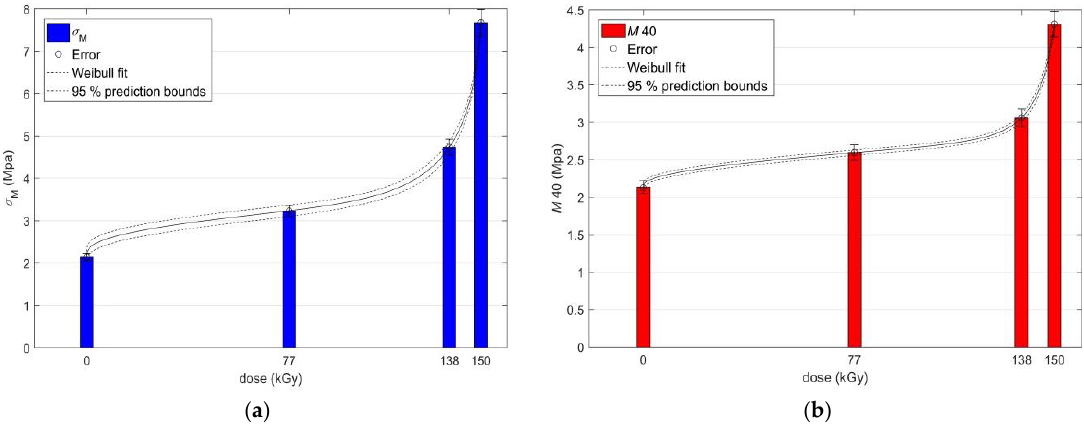
dose; ( b ) Regression analysis of the functional dependence of stress at break σ b on the radiation dose.